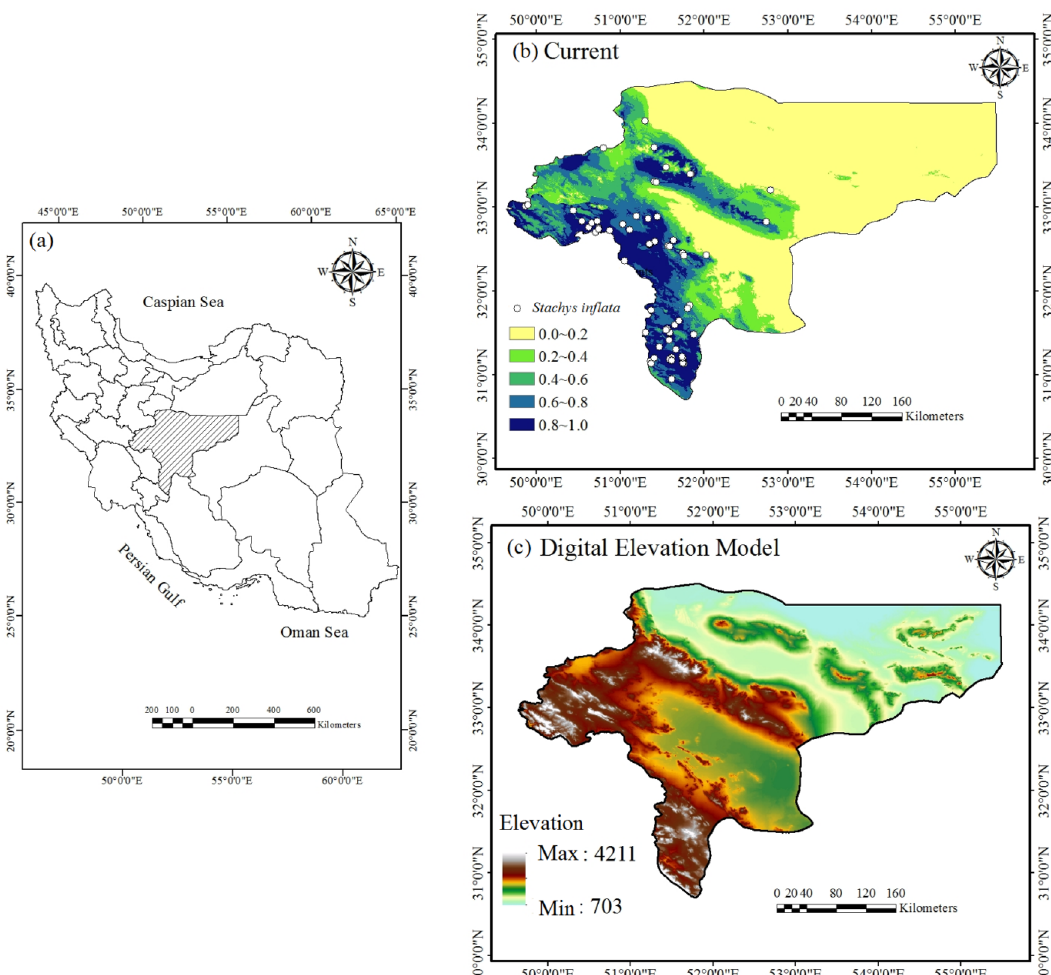
Figure 2. Isfahan Province is located in central Iran ( a ), the ensemble projects for climates presently suitable for S. inflata ( b ), and the digital elevation model (DEM) of Isfahan province ( c